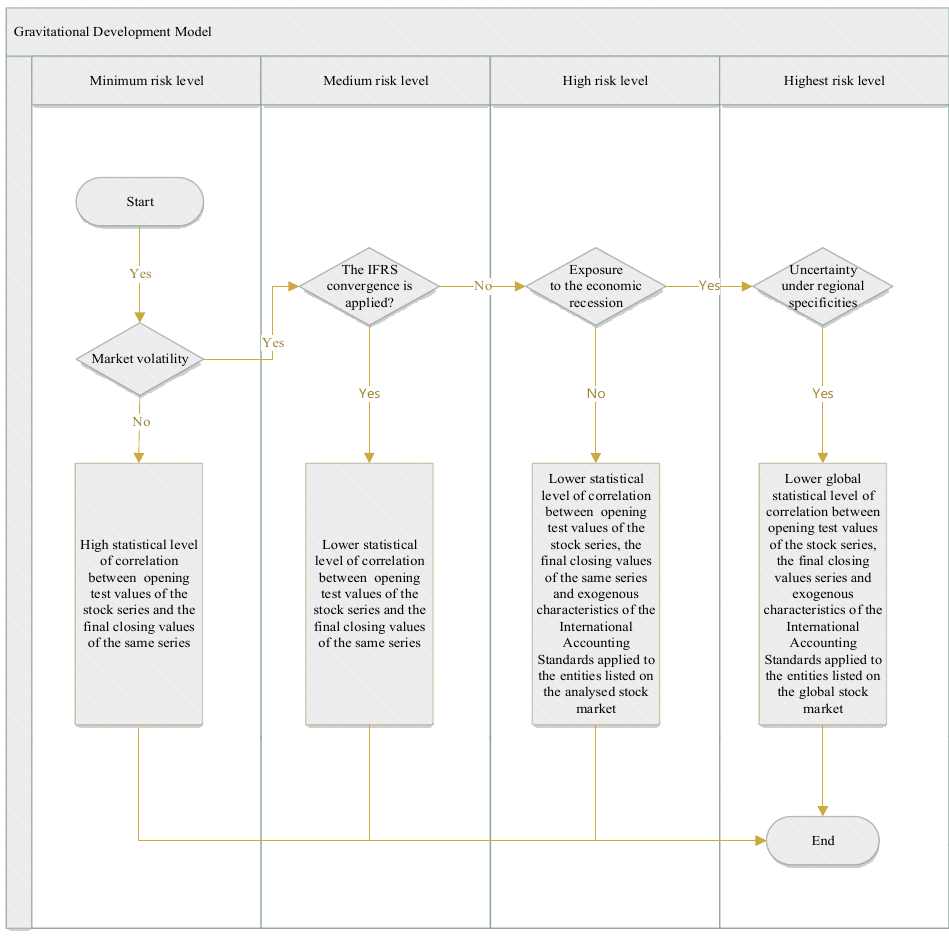
Figure 1. Logical scheme of the gravity model that was proposed by the authors.